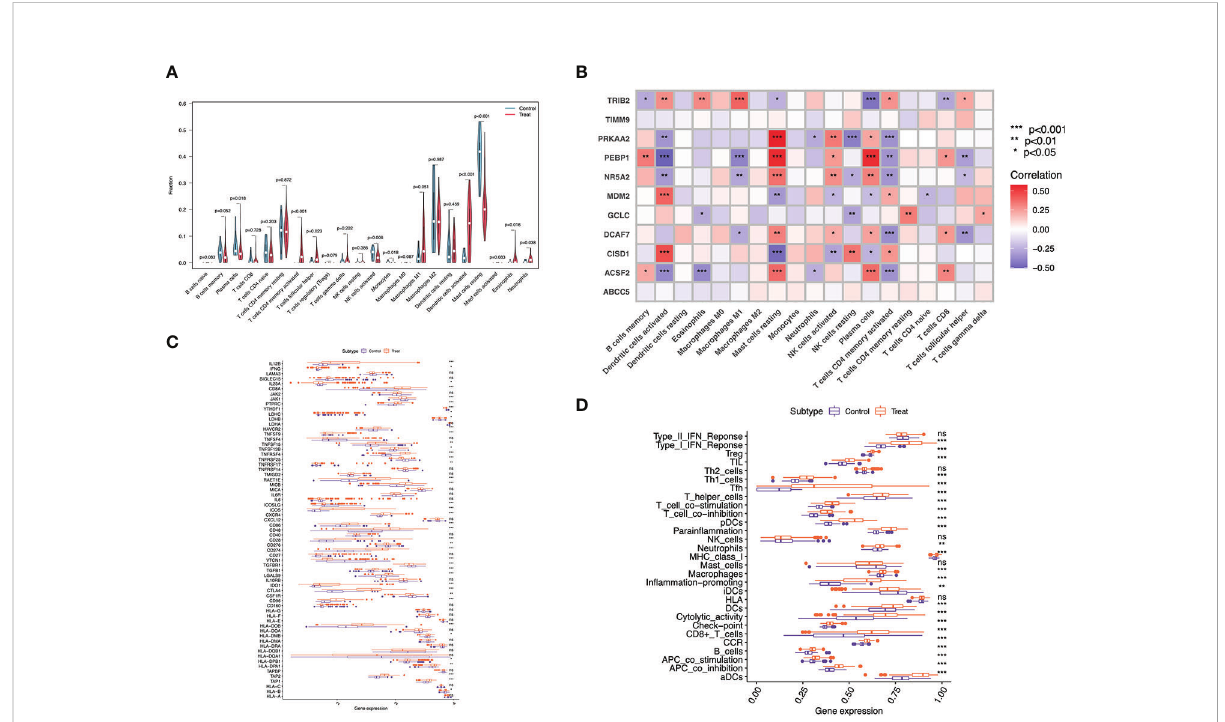
FIGURE 3 Immune landscape analysis. (A) Implemented the CIBERSORT algorithm to explore the differences in the immune microenvironment between psoriasis patients and normal samples. (B) Pearson correlation analysis (*p < 0.05, **p < 0.01,*** p < 0.001). (C) Immune gene expression and (D) immune function in psoriasis compared with normal